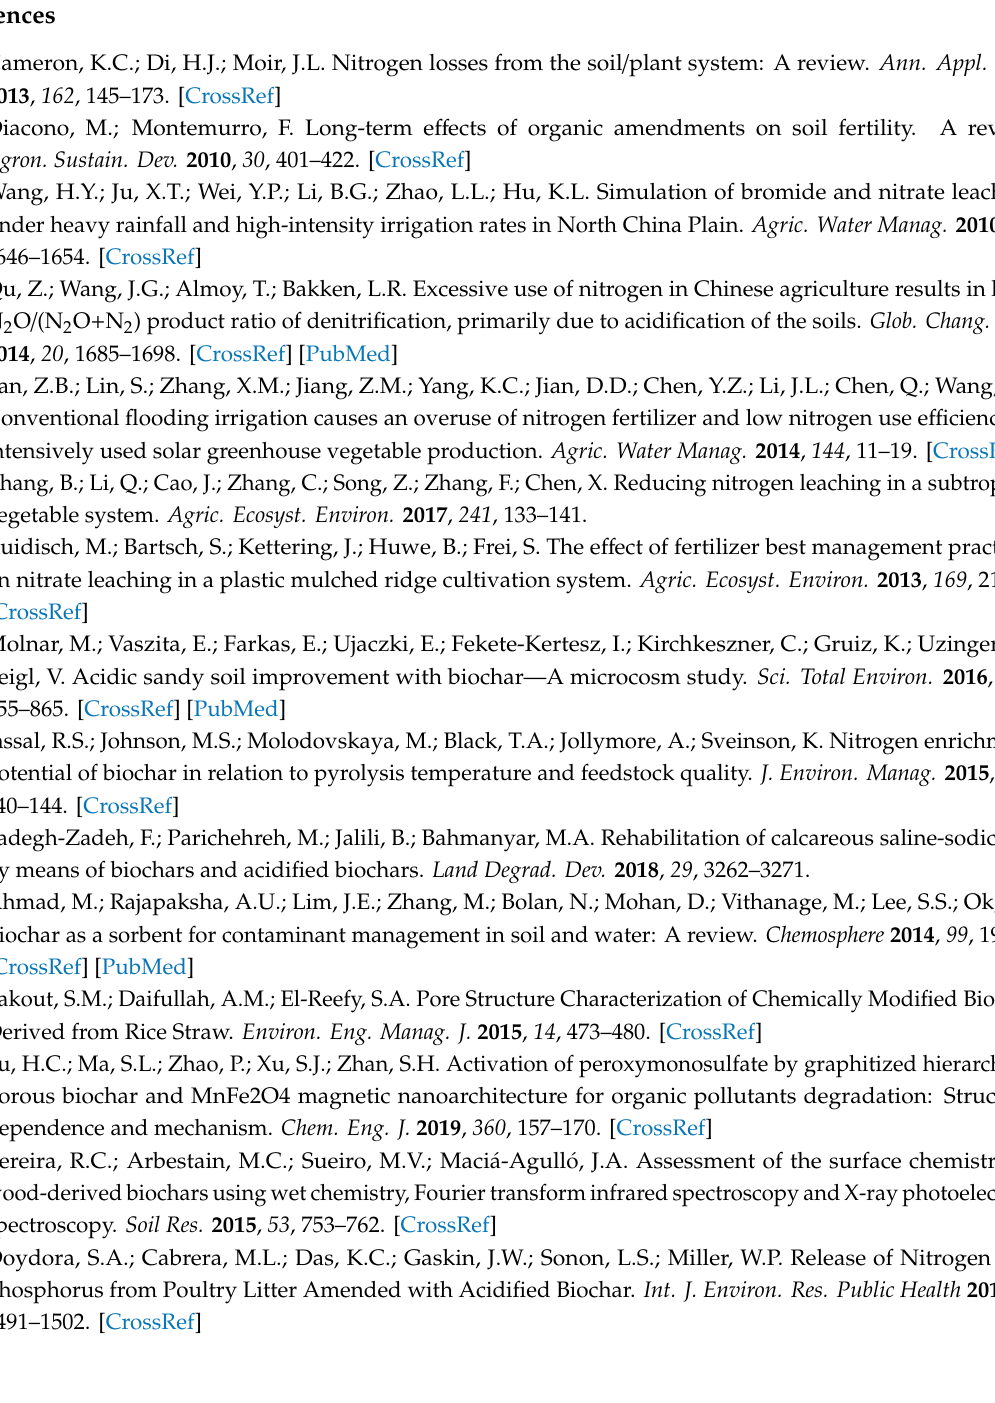
Figure S2: XPS spectra of C1s and O1s of PBC before and after NH 4 + -N adsorption, Figure S3: XPS spectra of C1s and O1s of H 2 O 2 -PBC before and after NH 4 + -N adsorption, Figure S4: SEM and EDS images of the five biochars. (a,b,c,d,e represent the adsorption of NH 4 + before and after PBC, H 2 O-PBC, HCl-PBC, H 2 SO 4 -PBC, and H 2 O 2 -PBC,